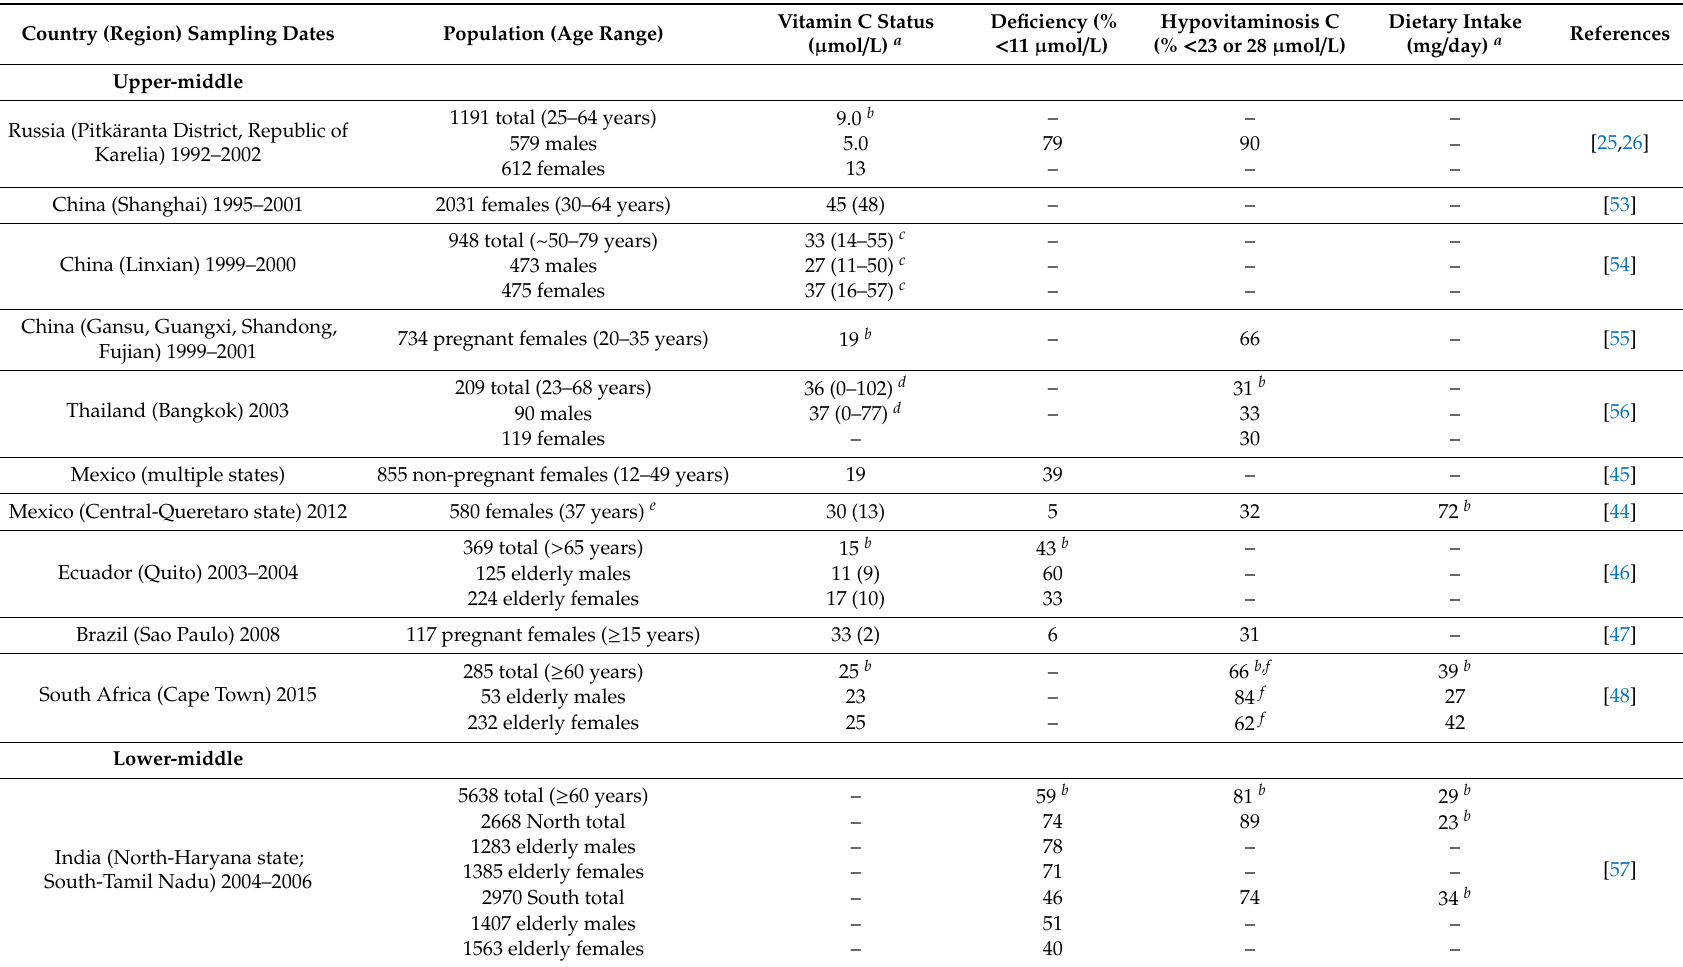
Table 2. Vitamin C status and prevalence of deficiency and hypovitaminosis C of adults in low- and middle-income